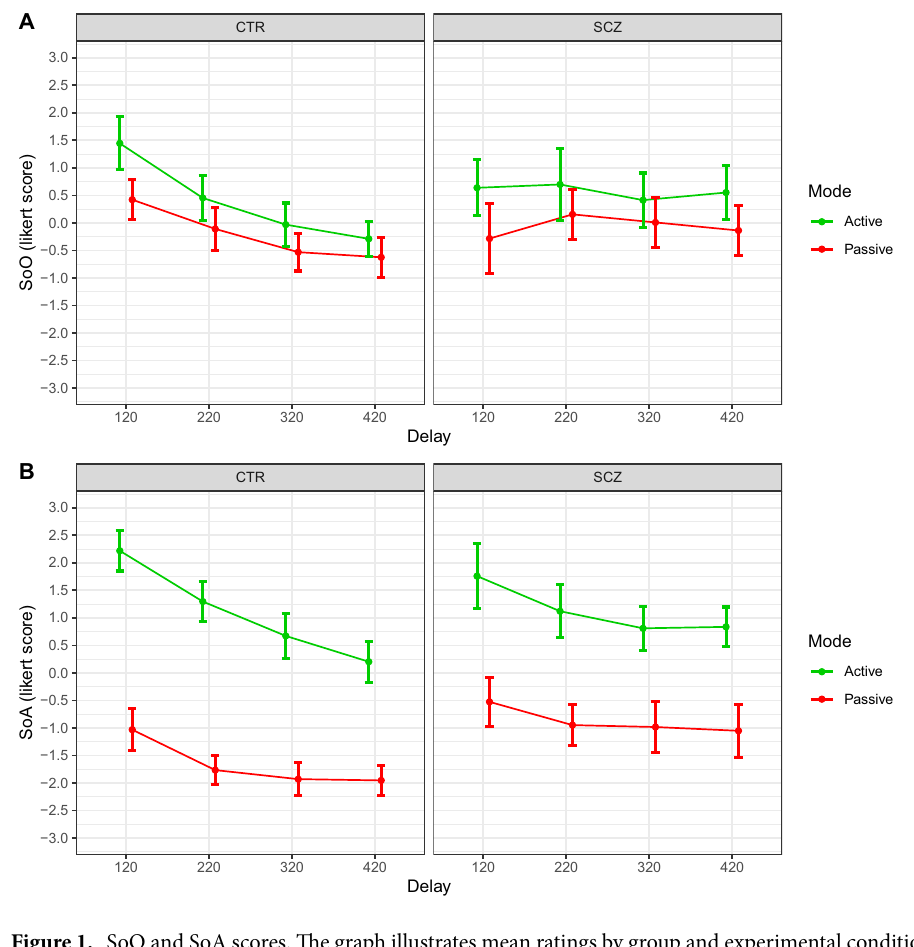
Figure 1. SoO and SoA scores. The graph illustrates mean ratings by group and experimental condition (( A ) SoO, ( B ) SoA). Green and red lines represent active and passive conditions respectively. Error bars = 95% confidence intervals.